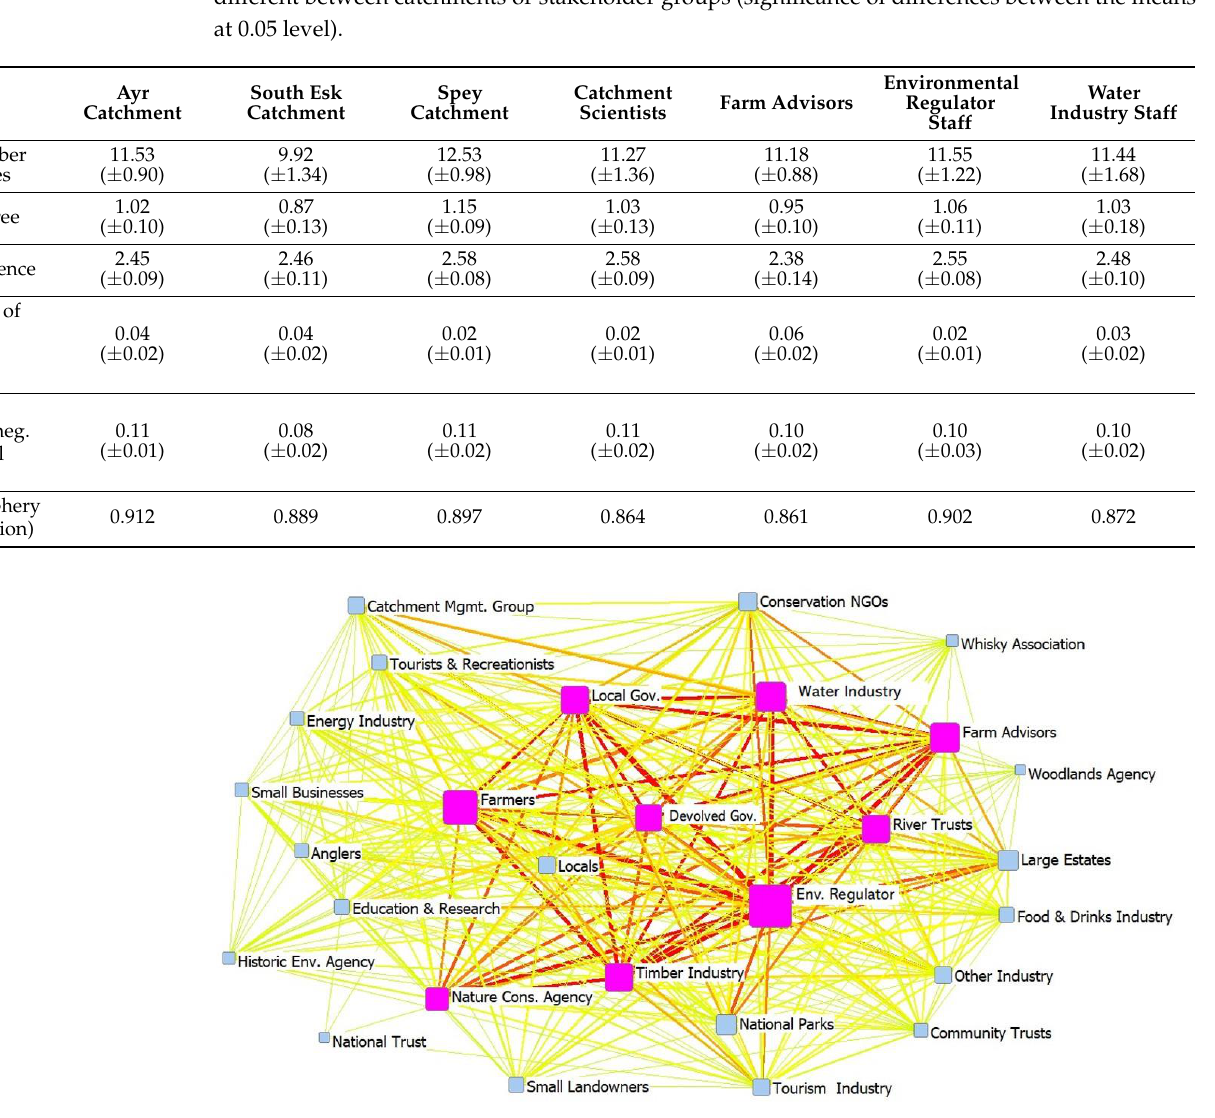
Figure 4. One-mode network of the stakeholder typologies, with node size depicting degree score and node colour showing the core (pink) and periphery (blue). Core/Periphery fit (correlation) = 0.9211. Ties depict co-occurrence of stakeholders from participant responses and tie strength is visualised both by line thickness and colour, with green depicting low tie strength (max. = 192). The core stakeholders from the Ayr catchment were identical to the Esk’s eight nodes,